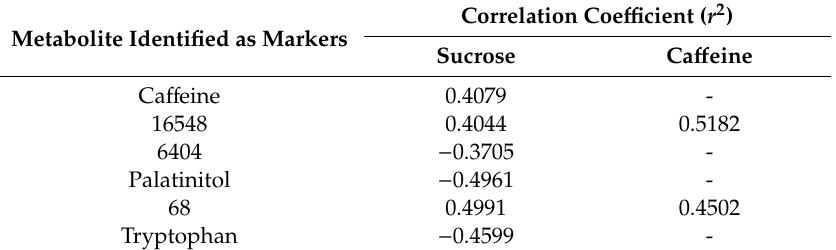
Table 2. Metabolites showing similar correlation pattern with sucrose and ca ff eine ( p <